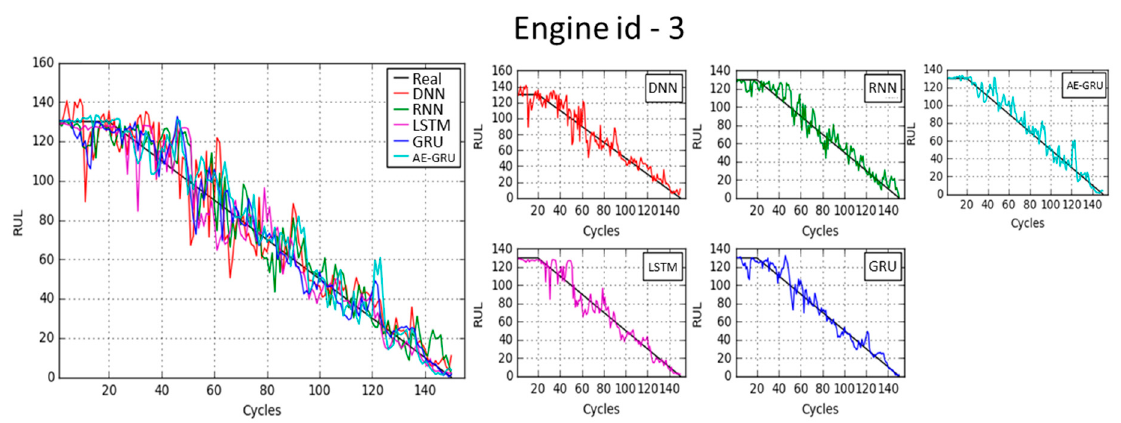
Figure 12. Model testing results comparison (Engine 3).